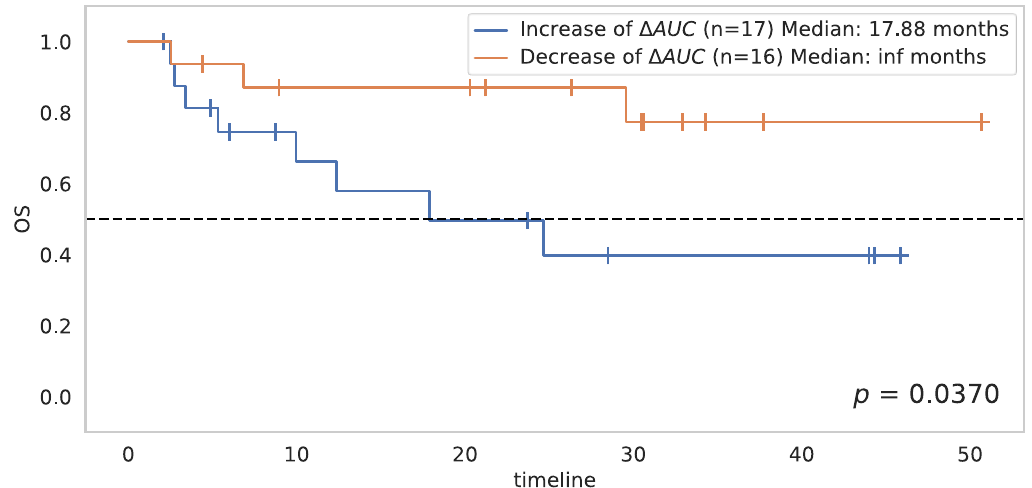
Figure 9. Survival in accordance with AUC variation from D8 to D21 ( ∆ AUC decrease of any amount) in the 33 patients with DCE-US at D8 and D21.